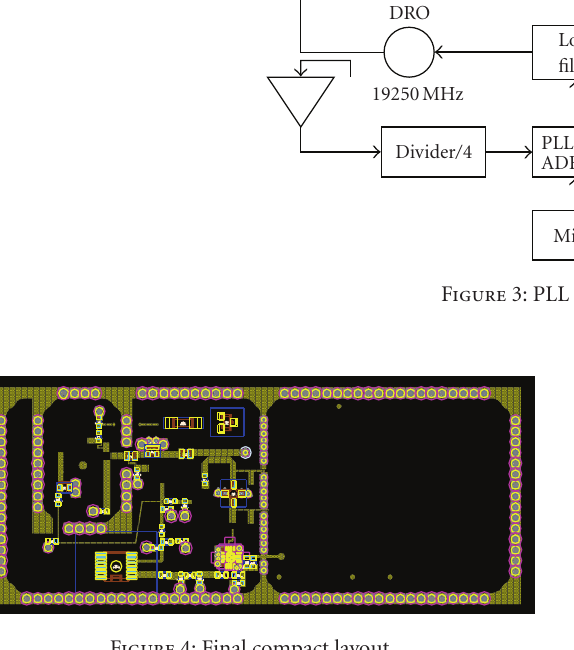
Figure 4: Final compact